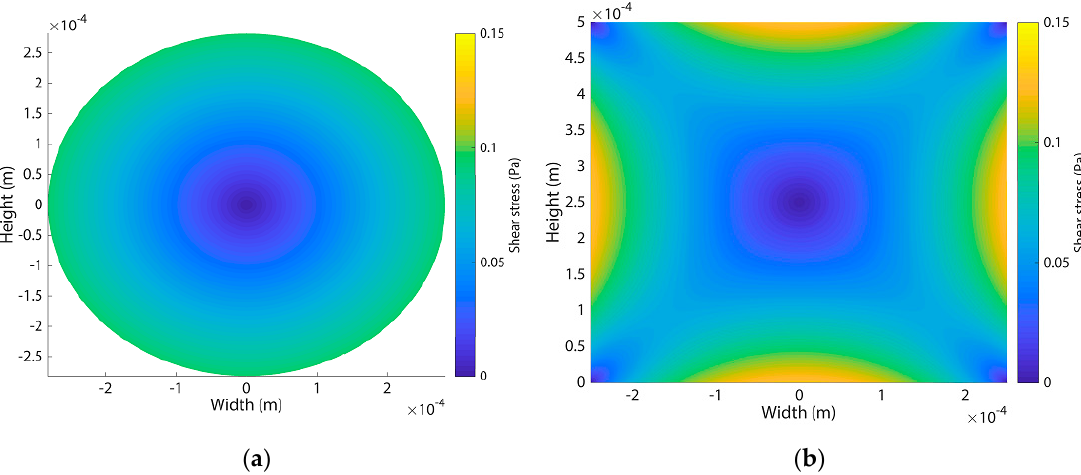
Figure 7. Theoretical shear stress profile in a circular and square cross-sectional channel of similar dimensions (diameter 564 µm vs. 500 × 500 µm) with a flow rate of 100 µL/min ( a ) Shear stress profile for a circular cross-sectional channel showing uniform shear stress along the wall and a radial symmetry; ( b ) Shear stress profile for a square cross-sectional channel showing a flattened parabolic profile along the wall with vanishing shear stress in the corners of the channel.